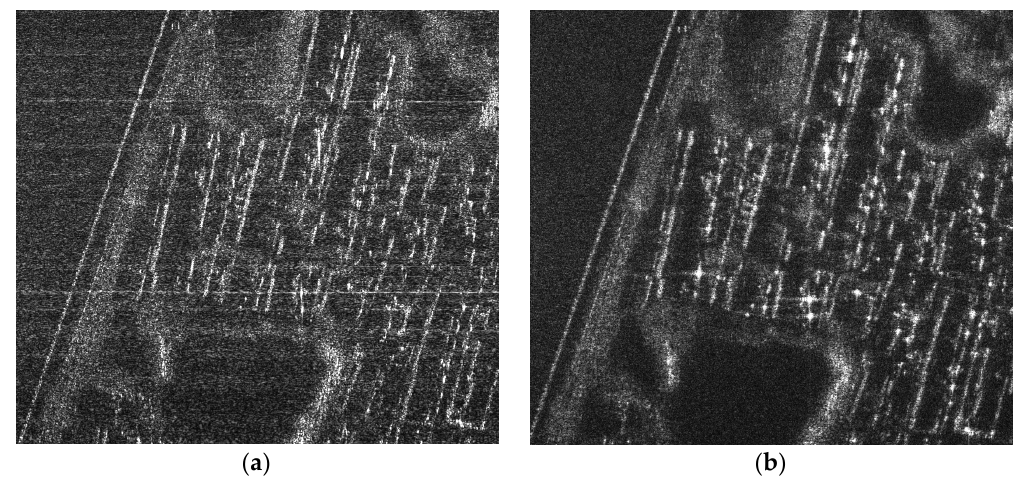
Figure 1. ( a ) Point spread function of the chirp; ( b ) compression result of the superposed echoes.